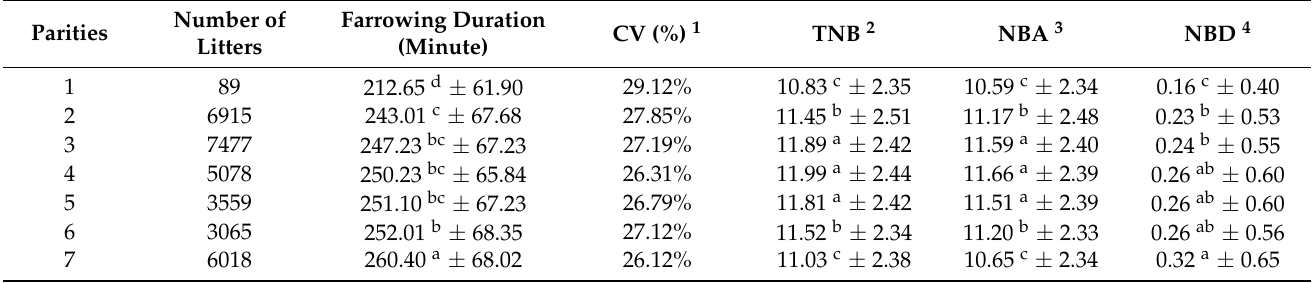
Table 5. Descriptive statistics of farrowing duration and litter size of different parities.